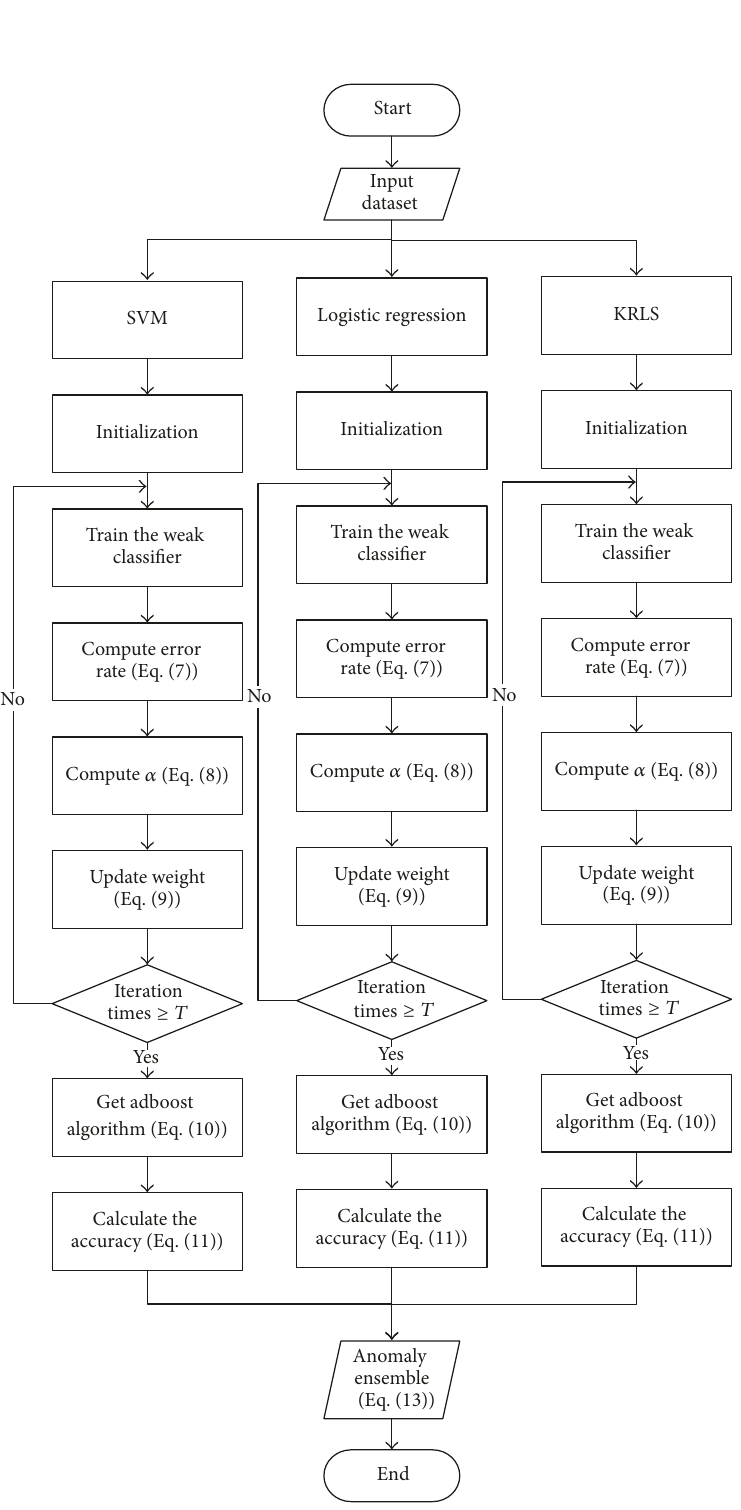
Figure 1: Workflow of HELM